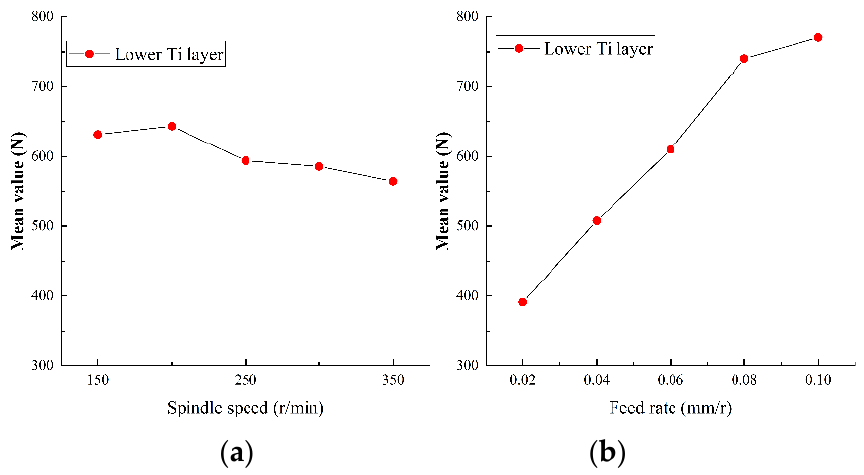
Figure 12. Main effect plots of axial force for drilling CFRP in ( a ) spindle speed and ( b ) feed rate.